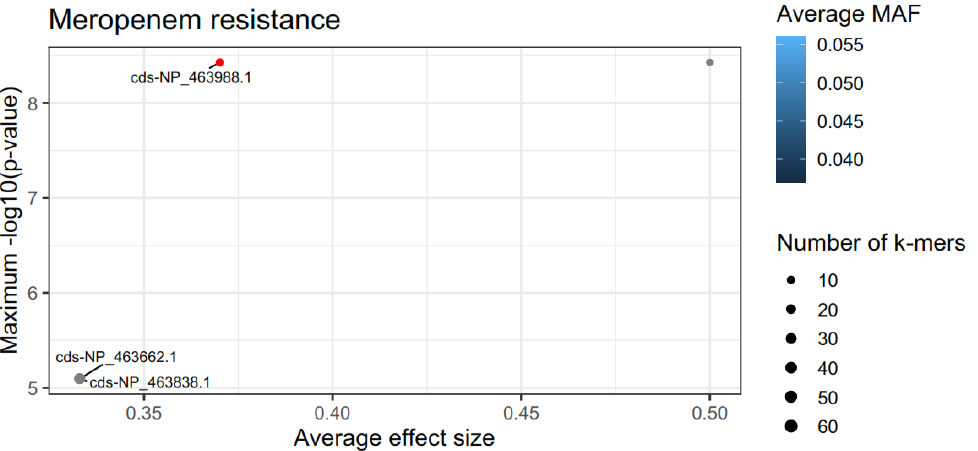
Figure 7. Summary plot obtained from GWAS analysis on the significant k-mers related to MEM- resistance of L. monocytogenes AAL 20187 strain.